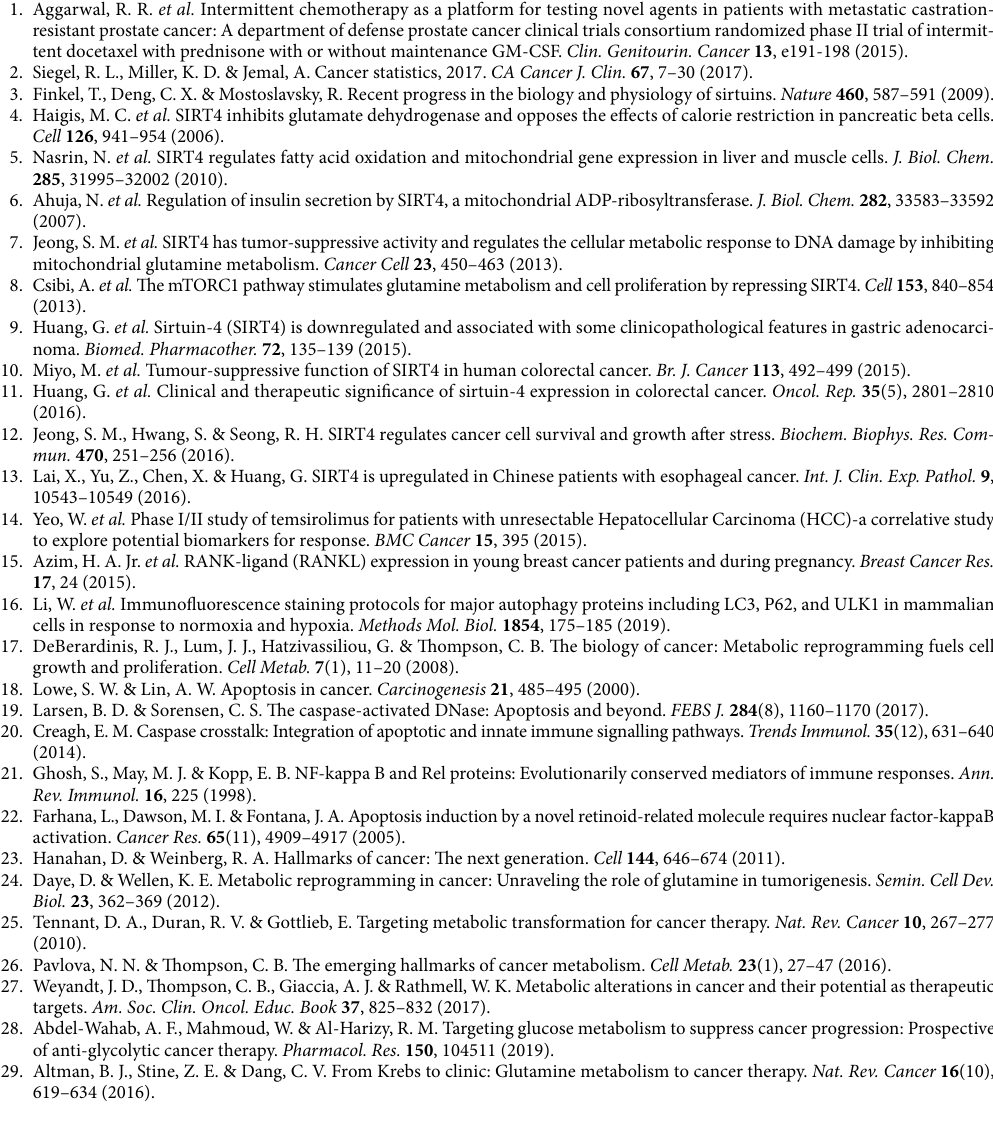
Figure 5. Regulation of cellular mobility by SIRT4 via suppression of glutamine metabolism. ( A ) The relative density of MMP9, E-cadherin, and N-cadherin proteins after comparison with GAPDH; the density is analyzed and quantified using the Image J software. The original blots are represented in Supplementary Fig. 4. ( B ) Glutamate dehydrogenase activity in control and 22RV1 cells overexpressing SIRT4. ( C ) Glutamate dehydrogenase activity in control and SIRT4 knockdown 22RV1 cells. (D) The proliferation activity of control vector-transfected and SIRT4-overexpression in 22RV1 cells in stand media or media supplemented with DM-αKG (8 mmol/L). Cell proliferative activity is measured at 72 h after seeding the cell. ( E , F ) The wound- healing assay with SIRT4-overexpressing 22RV1 ( E ) and control cells ( F ) treated with DM-αKG for 0 and 24 h, respectively. Representative images at the indicated time points are shown on the left (scale bar, 100 mm). ( G,H ) The cell invasion assay in SIRT4-overexpressing 22RV1 cells ( G ) and control cells ( H ) treated with DM-αKG after incubation for 0 and 24 h, respectively. Representative images at the indicated times are on the left (scale bar, 100 mm). Data are presented as mean ± SD of at least three independent experiments.** P < 0.01; NS, not